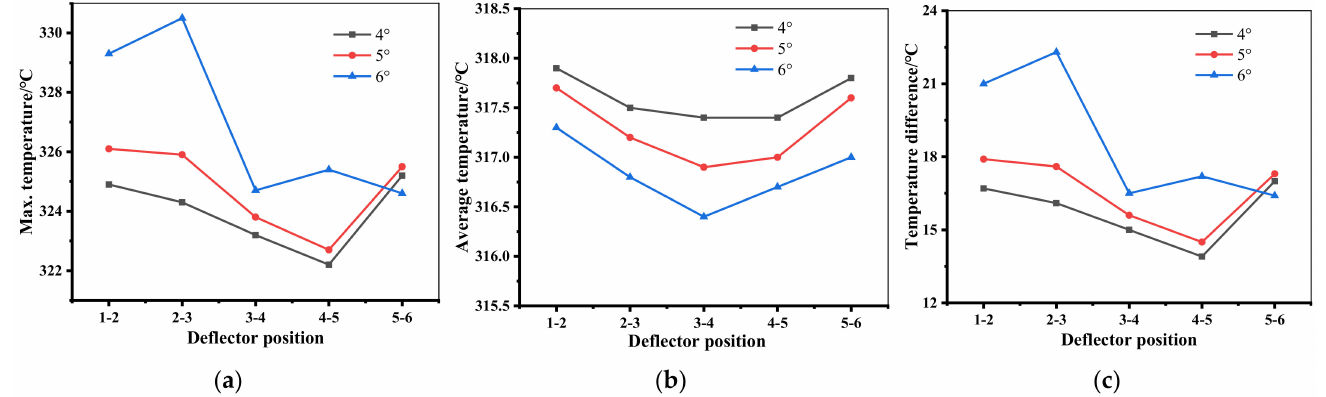
Figure 17. Temperature change curves for the battery pack: ( a ) the maximum temperature change curve; ( b ) the average temperature change curve; and ( c ) the temperature difference curve.